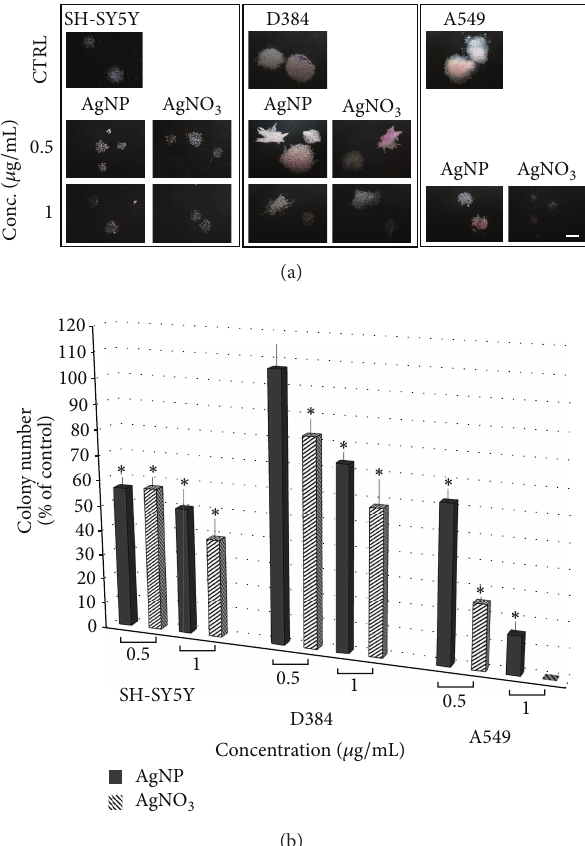
Figure 5: Data comparison between AgNPs and AgNO 3 in SH- SY5Y, D384, and A549 cells for clonogenic assay. Panel (a) shows images of selected microscopic fields from control and treated cells with AgNPs or AgNO 3 at 0.5 and 1 𝜇 g/mL for up to 10 days (scale bar is 600 𝜇 m). Panel (b) shows the respective semiquantitative analysis for the colony number of SH-SY5Y, D384, and A549 after AgNPs or AgNO 3 treatment. AgNO 3 induced a more pronounced effect on growth and cell proliferation than AgNP treatment regardless of cell model type. ∗ Different from control in cell line 𝑃 < 0.05 , statistical analysis by ANOVA followed by Tukey’s